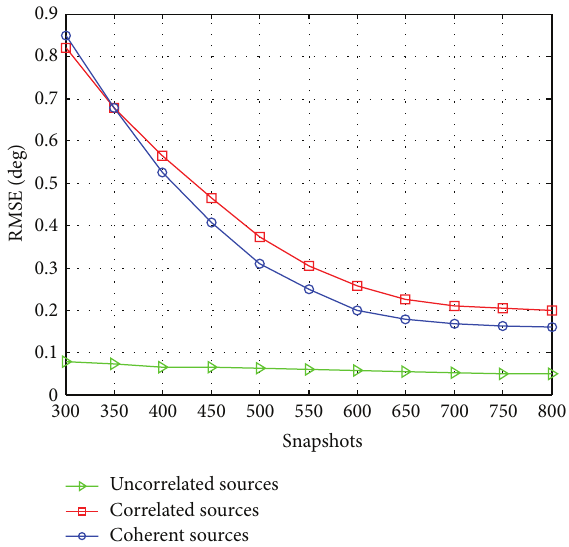
Figure 6: RMSE of the proposed method versus input SNR for the uncorrelated, correlated, and coherent signals.